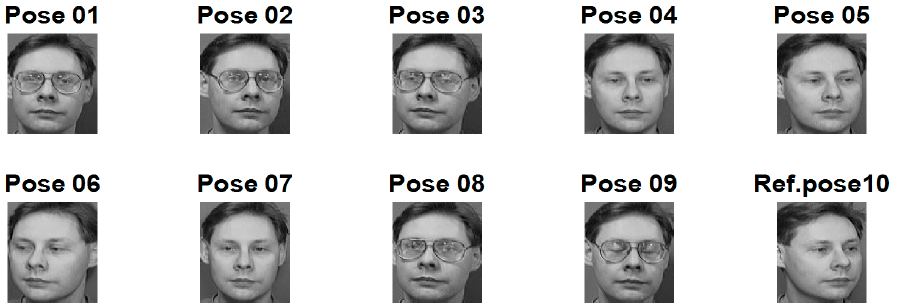
Figure 3. Poses for person No. 4 in AT&T database. Appl. Sci. 2017 , 7 , 786